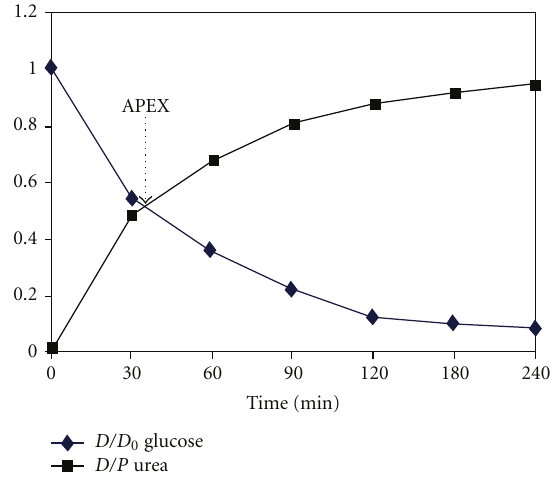
Figure 3: Illustration of APEX time, the crossing point of dialytic urea appearance, and glucose disappearance curve. APEX time indicates the optimal dwell time for ultrafiltration (normal range: 18 to 71 minutes).